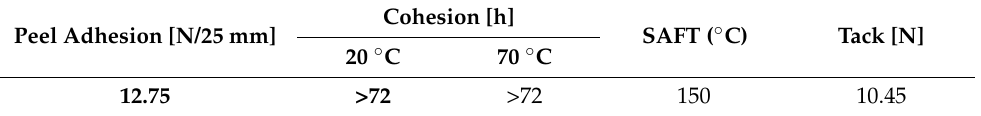
Table 3. Q2 7358 pressure-sensitive adhesive results without